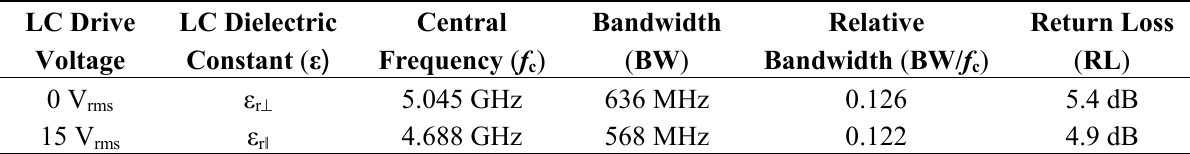
Table 4. Summary of the experimental measurements of the spectral response for the new LC bandpass filter.